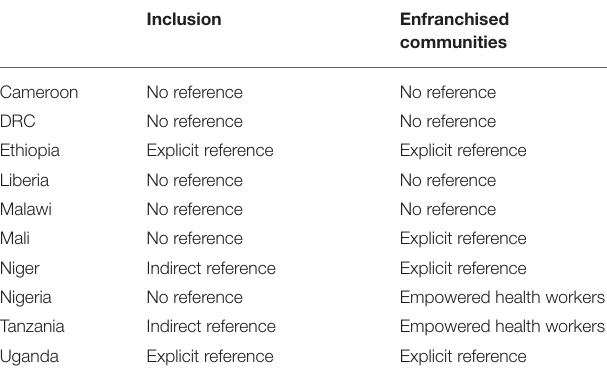
TABLE 7 | References to inclusion and enfranchised communities within digital health strategies.